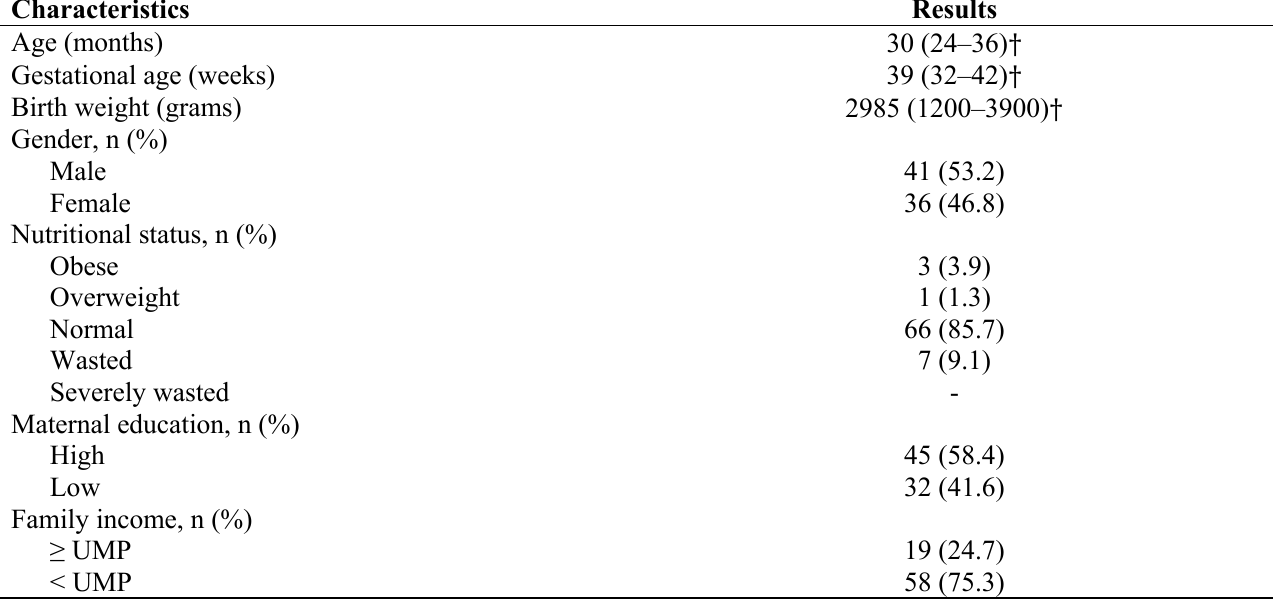
Table 1. Subjects’ characteristics